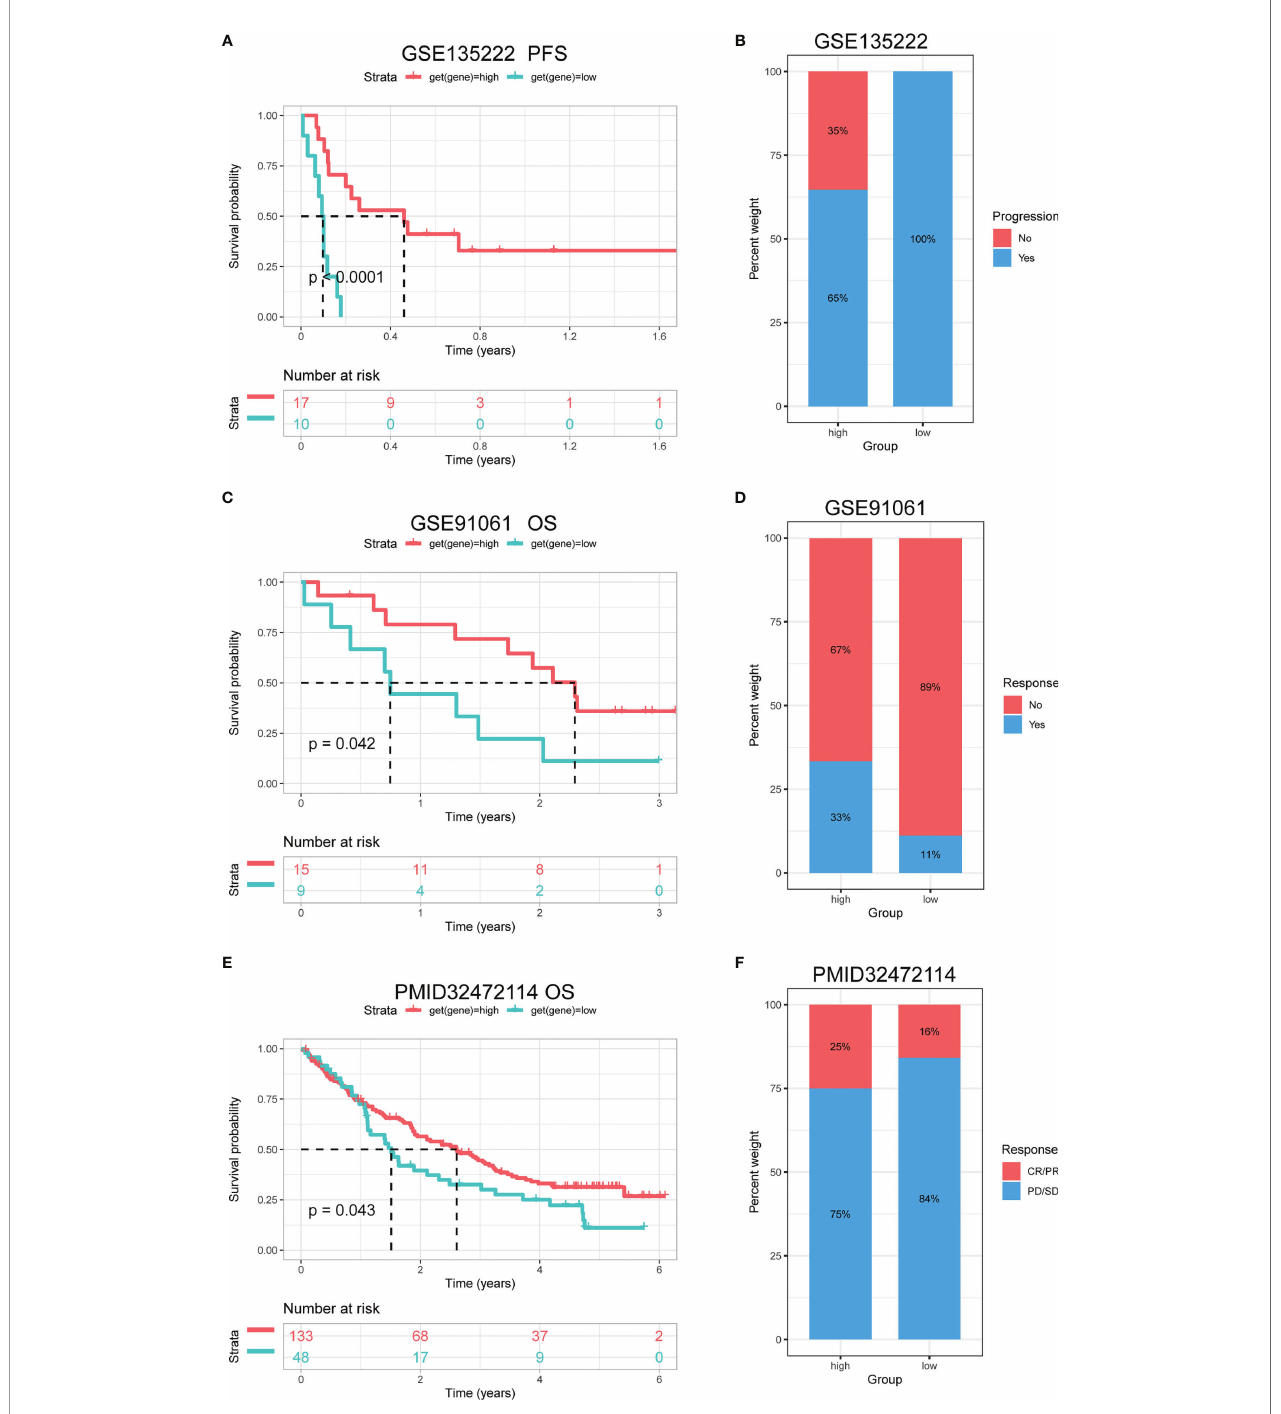
FIGURE 14 | The association between TRP score and immunotherapy response. (A) The Kaplan-Meier PFS analysis of TRP score in GSE135222 cohort. (B, D, F) The percentage of responsive and progressive patients in high- and low-TRP score groups in (B) GSE135222, (D) GSE91061, and (F) PMID32472114 cohorts. (C, E) The Kaplan-Meier OS analysis of TRP score in (C) GSE91061 and (E) PMID32472114 cohorts. CR, complete response; OS, overall survival; PD, progressive disease; PFS, progression-free survival; PR, partial response; SD, stable